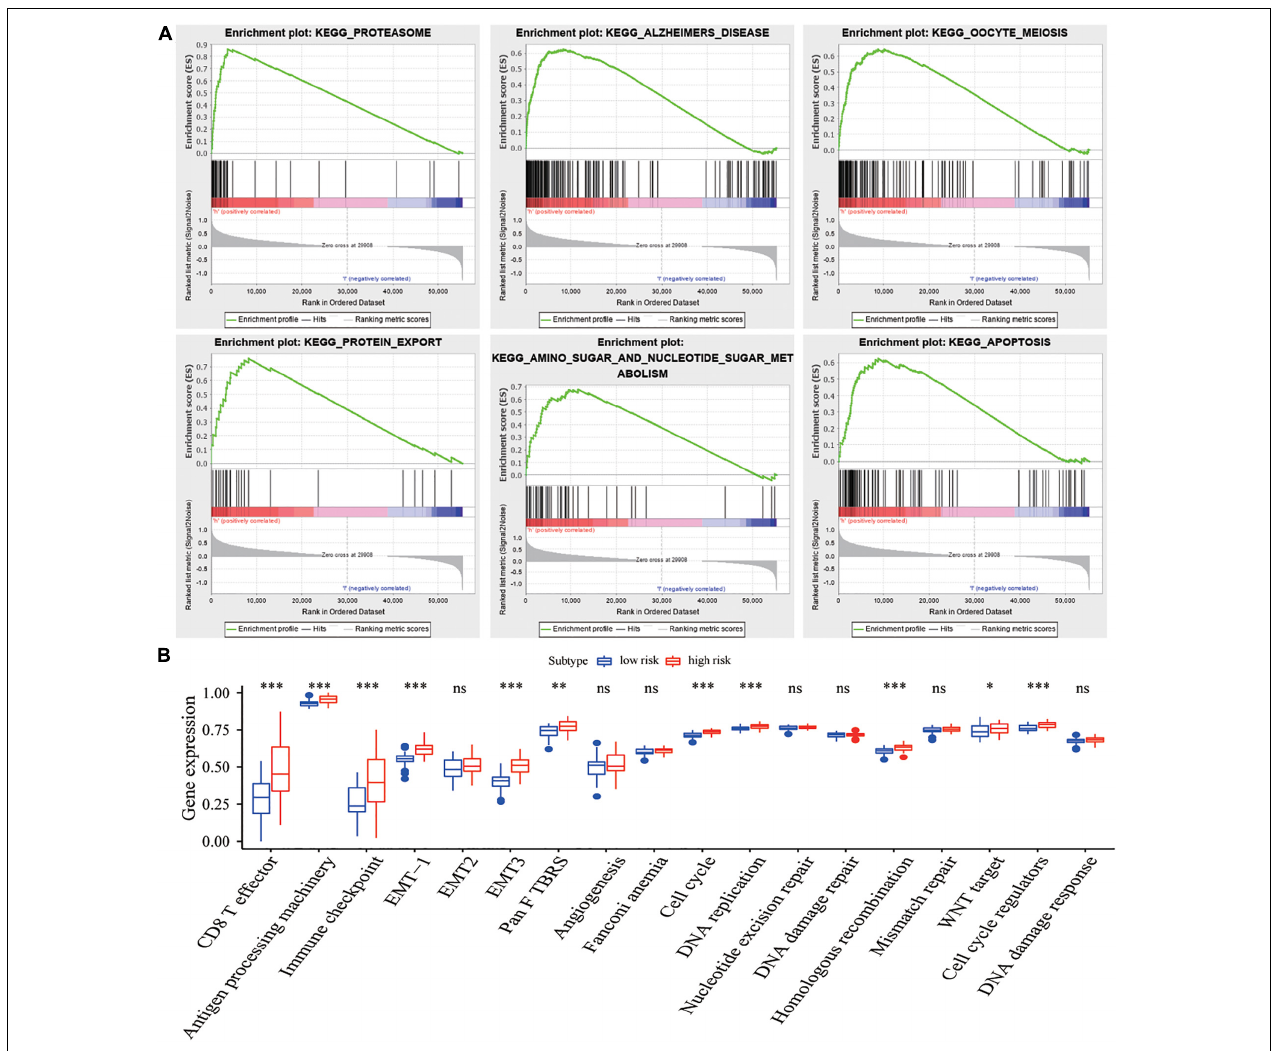
FIGURE 7 | Functional enrichment analysis of lncRNA signature. (A) Six representative KEGG pathways in the high-risk group via GSEA. (B) Comparisons of different pathway features between the high-risk and low-risk groups. * P < 0.05, ** P < 0.01, *** P <